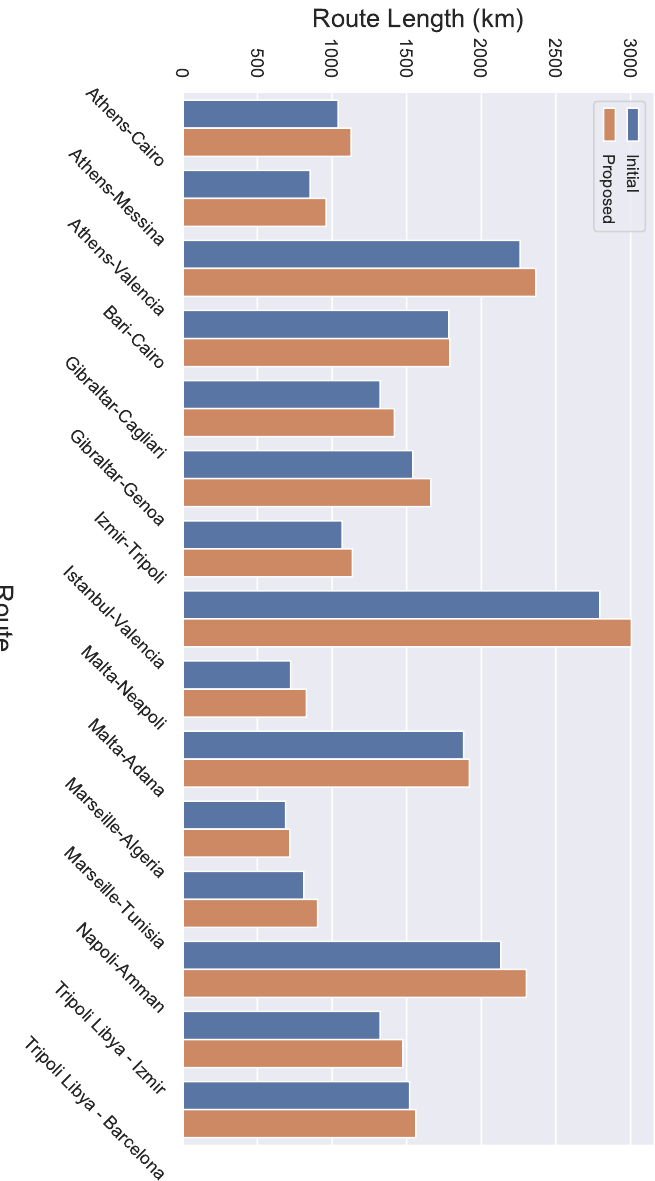
Figure 10. The length of the routes for both the initial and recommended